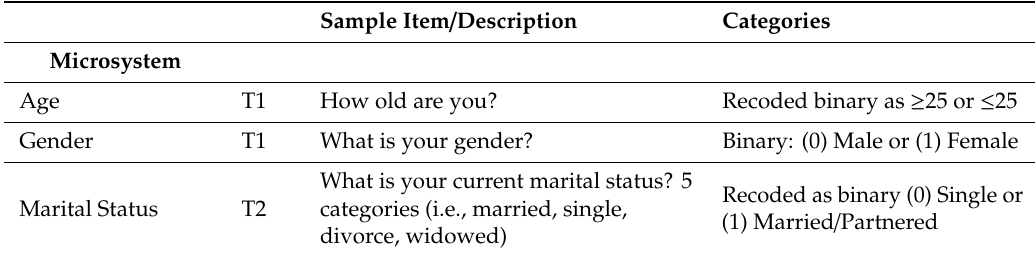
Table 1. Description of study